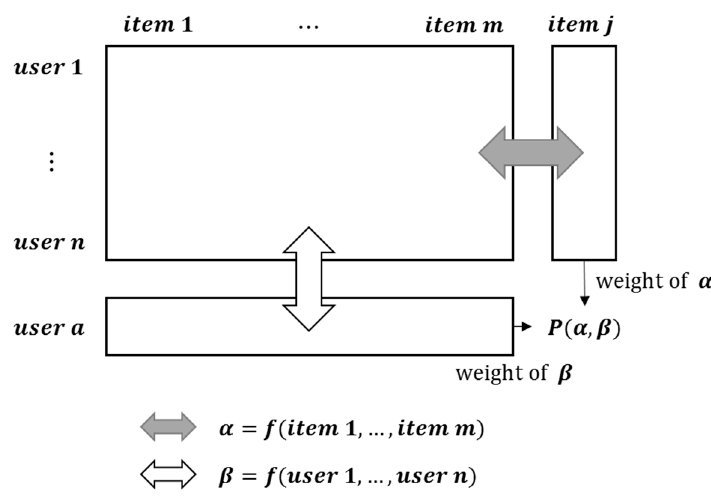
Figure 2. A schematization of the proposed two-way CF approaches.